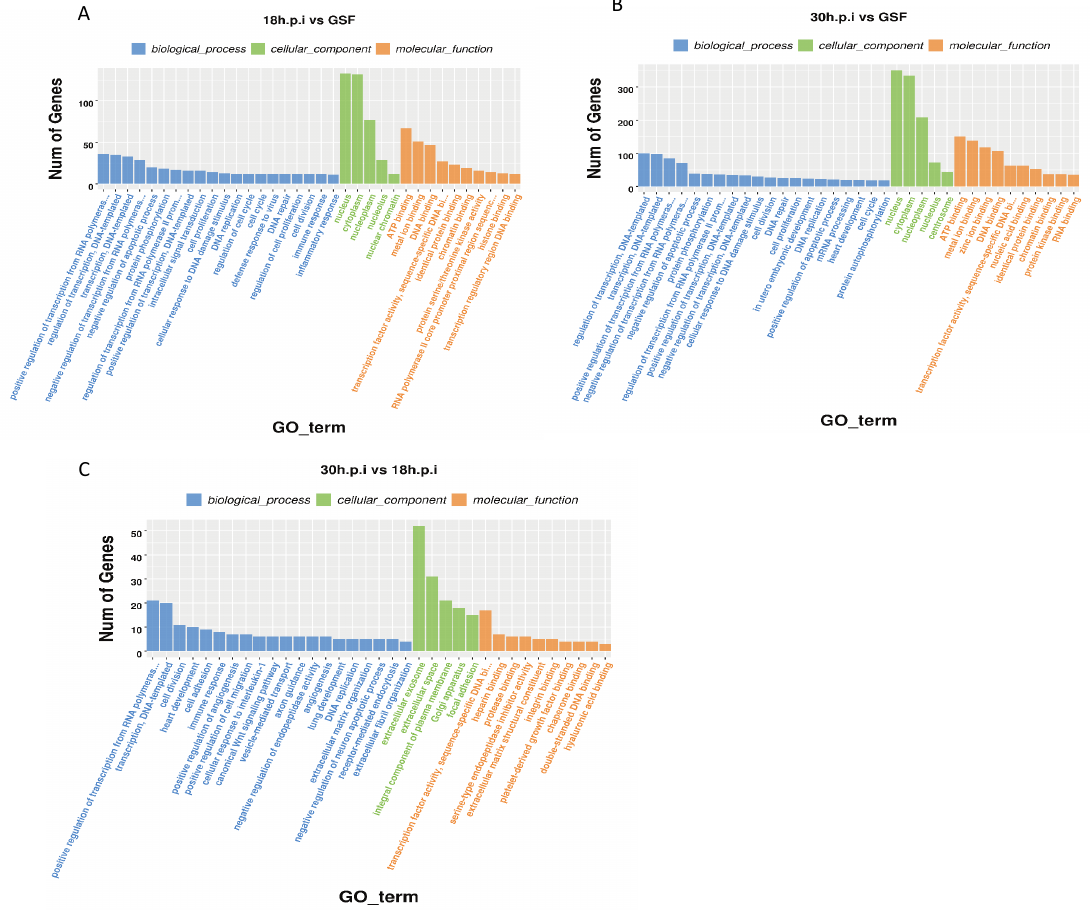
Figure 5. GO enrichment analyses of DEGs in 18h.p.i vs. GSF, 30h.p.i vs. GSF and 30h.p.i vs. 18h.p.i. ( A ) GO enrichment analysis of DEGs in 18h.p.i vs. GSF. ( B ) GO enrichment analysis of DEGs in 30h.p.i vs. GSF. ( C ) GO enrichment analysis of DEGs in 30h.p.i vs. 18h.p.i.